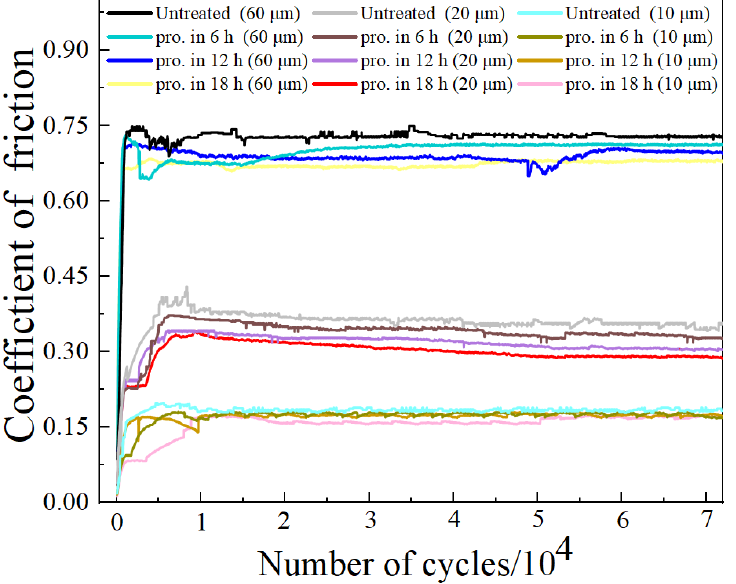
Figure 7. Evolution of COF for GCr15 steel balls specimens with different process times at different displacement amplitudes.